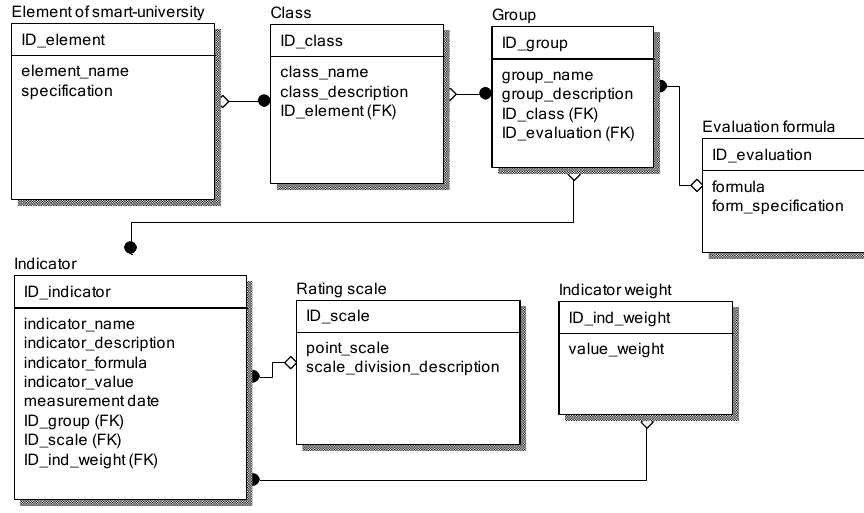
Fig. 3. ER-model for assessing the smart university infrastructure development